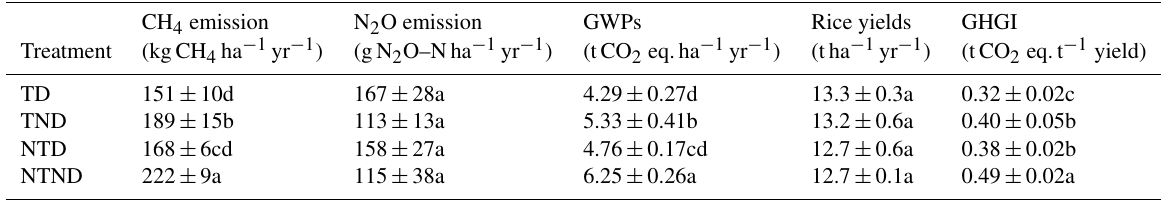
Table 3. Mean annual CH 4 and N 2 O emissions, global warming potentials (GWPs) of CH 4 and N 2 O emissions, rice grain yields, and greenhouse gas intensity (GHGI) over the 4 years from 2010 to